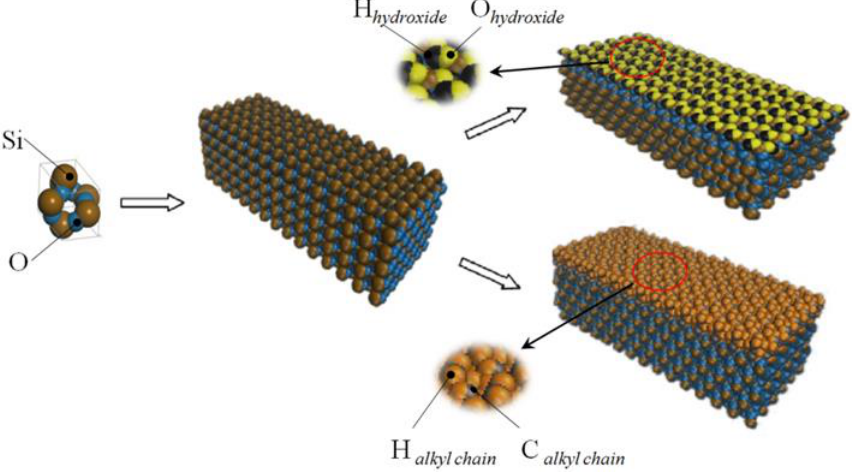
Figure 2. The modeling process diagram of the nanochannel wall.